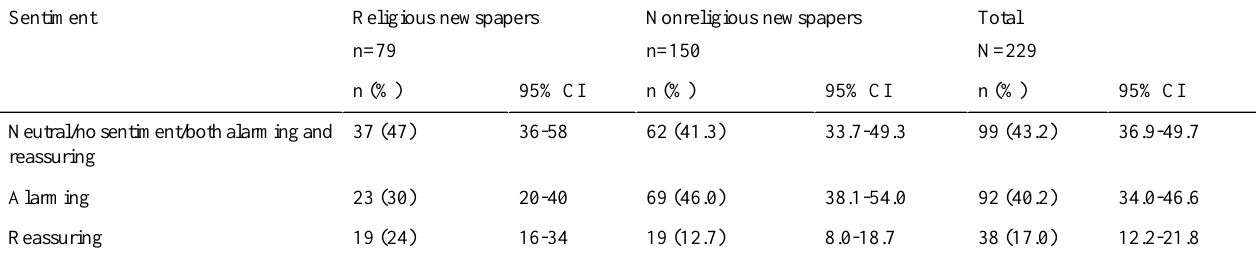
Table 7. Sentiments of coded measles-related articles in religious- and nonreligious-oriented newspapers.